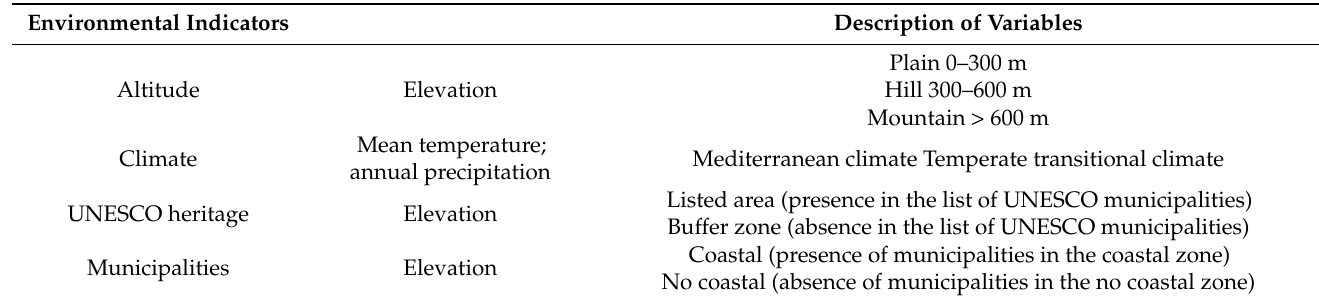
Table 2. Information of the independent